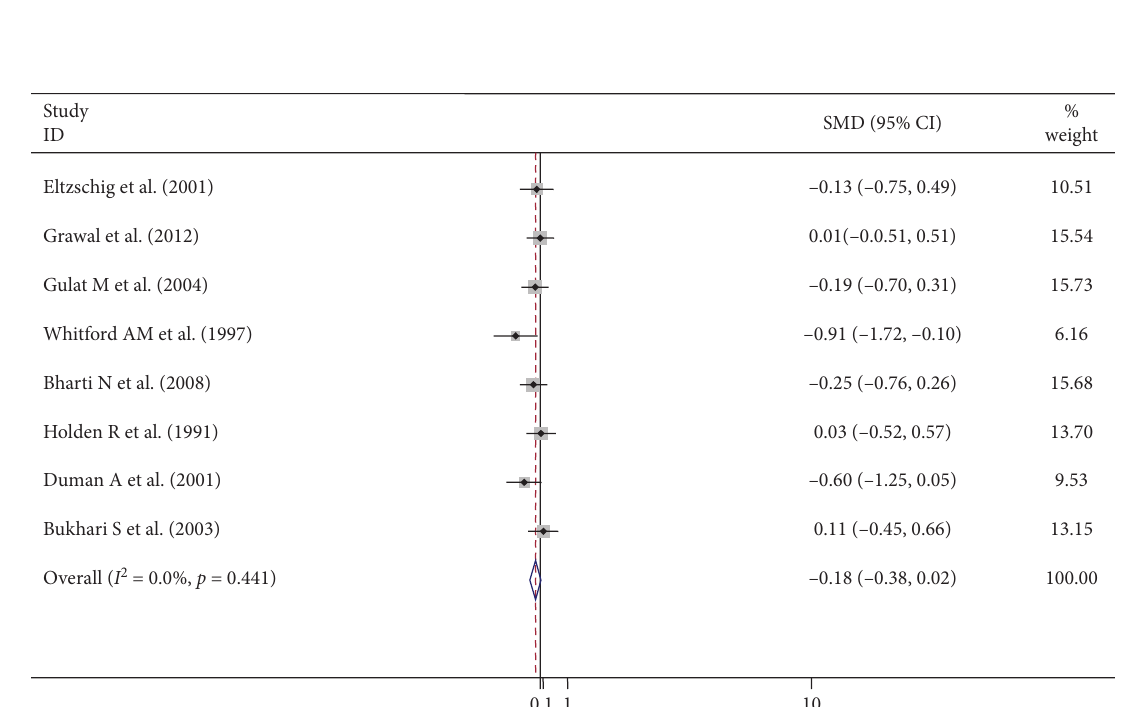
Table 2: Description of the studies included in the meta-analysis after insertion of LMA and ETT intubation. Author Eltzschig et al. Grawal et al. Whitford et al. Duman et al. Bukhari et al.